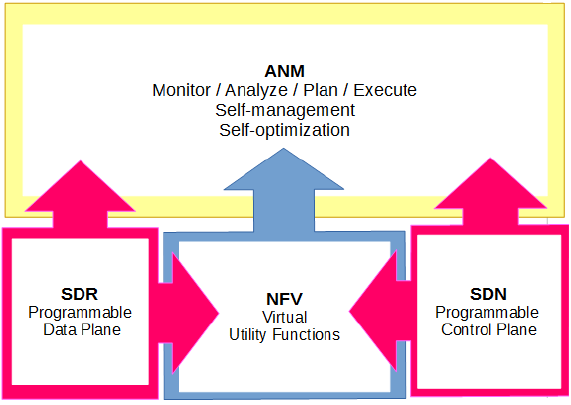
Figure 2. Autonomic Network Management combined with SDN/SDR/NFV: conceptual diagram and interactions between